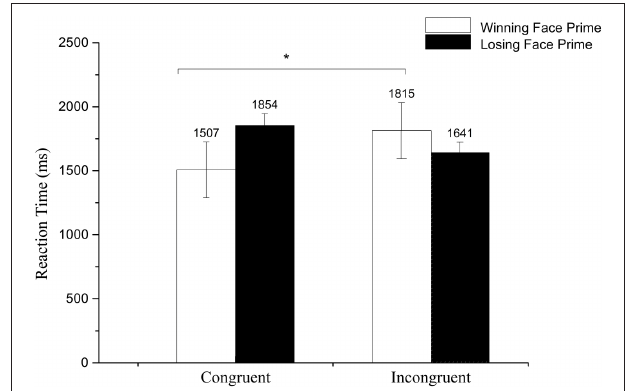
FIGURE 5 | Mean reaction time to losing and winning face primes in congruent and incongruent conditions. * p <